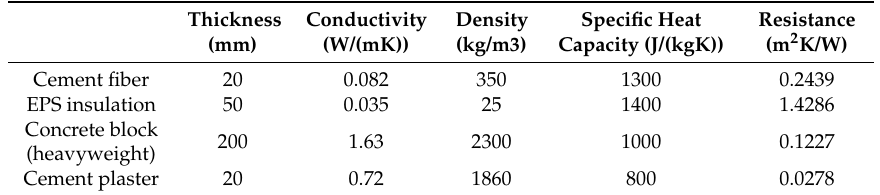
Table 2. Details of reinforced concrete (RC) external wall design in Beijing.